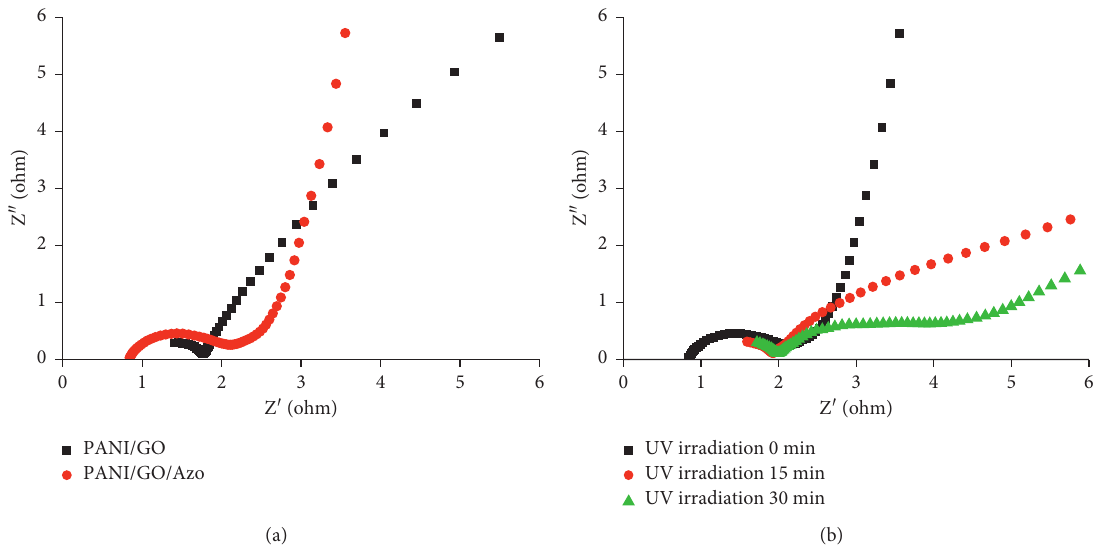
Figure 11: The Nyquist plots of (a) PANI/GO and PANI/GO/Azo composites; (b) PANI/GO/Azo composites at different UV irradiation